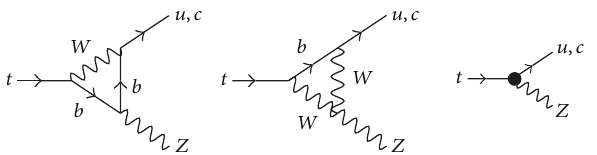
Figure 1: Feynman diagrams for FCNC rare top decays in the SM and induced at tree level by the presence of